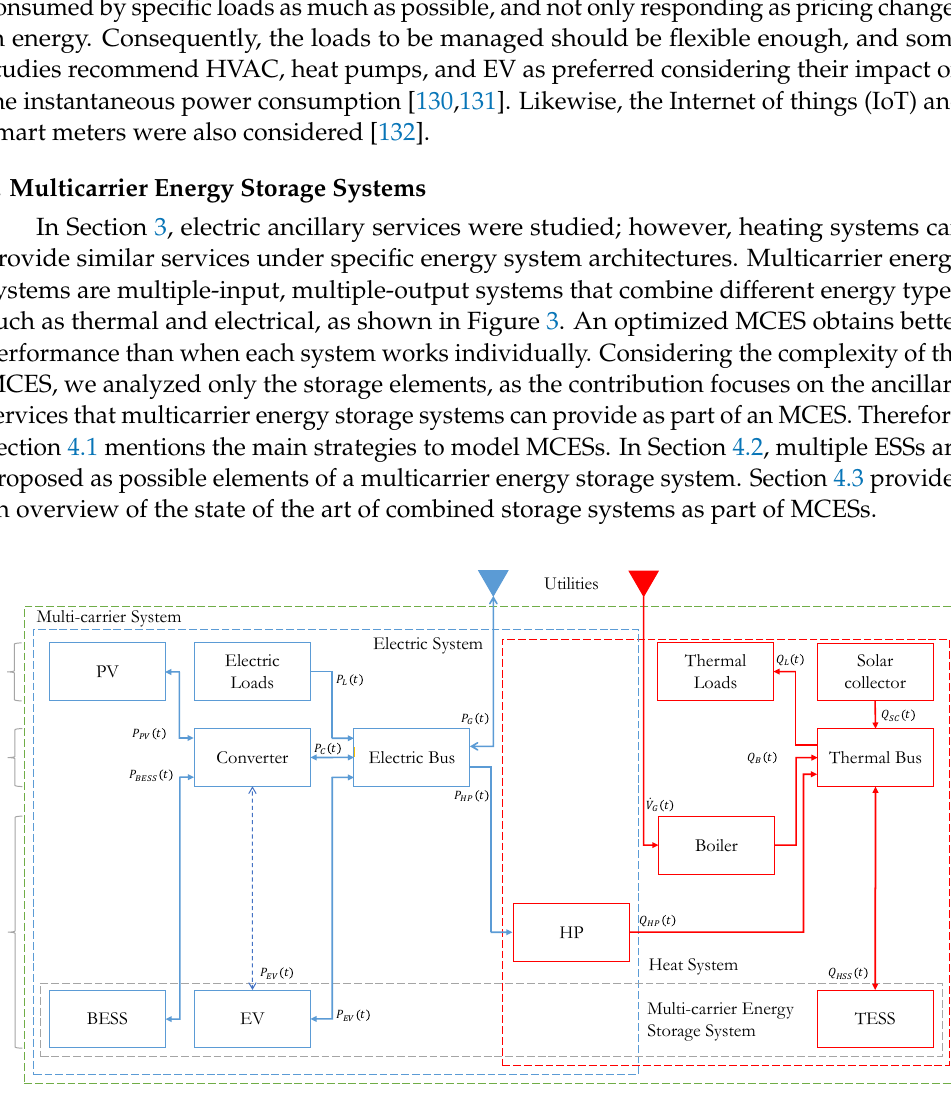
Figure 3. Schematic of the energy flow of a multicarrier energy storage system, where P PV represents the instantaneous power produced by the PV system, P BESS represents the instantaneous power provided/consumed by the BESS, P C represents the instantaneous power provided/consumed by the converter, P EV represents the instantaneous power provided/consumed by the EV converter (in some topologies, the EV charger is directly connected to the main converter; in others, the charger is connected to the electric bus), P HP represents the instantaneous power consumed by the HP, P L represents the instantaneous power consumed by the electric loads, P G represents the instantaneous power consumed from/delivered to the grid, Q SC represents the instantaneous heat produced by the solar collectors, Q HP represents the instantaneous heat produced by the heatpump, Q TESS represents the instantaneous heat provided/consumed by the TESS, Q B represents the instantaneous heat produced by the boiler, Q L represents the instantaneous heat consumed by the thermal loads, and ˙ V G represents the instantaneous flow of gas consumed from the